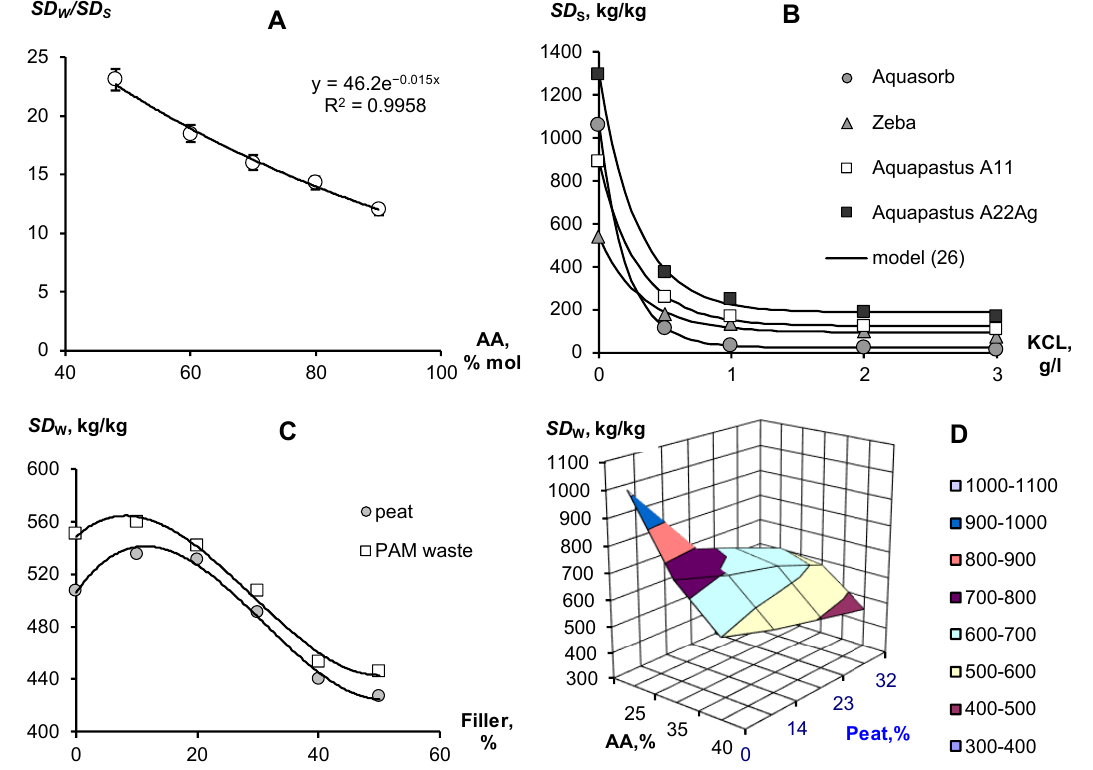
Figure 1. Composition and swelling of polymeric gel-forming materials (explanations in the text). ( A )— excess of swelling in water relative to KCl solution (3 g/L) depending on the proportion of acrylamide (AA); ( B )— dependence of the degree of swelling on the concentration of potassium chloride; ( C )— dependence of the degree of swelling on the content of fillers; ( D )— effect of the concentration of acrylamide and peat filler on the degree of swelling.